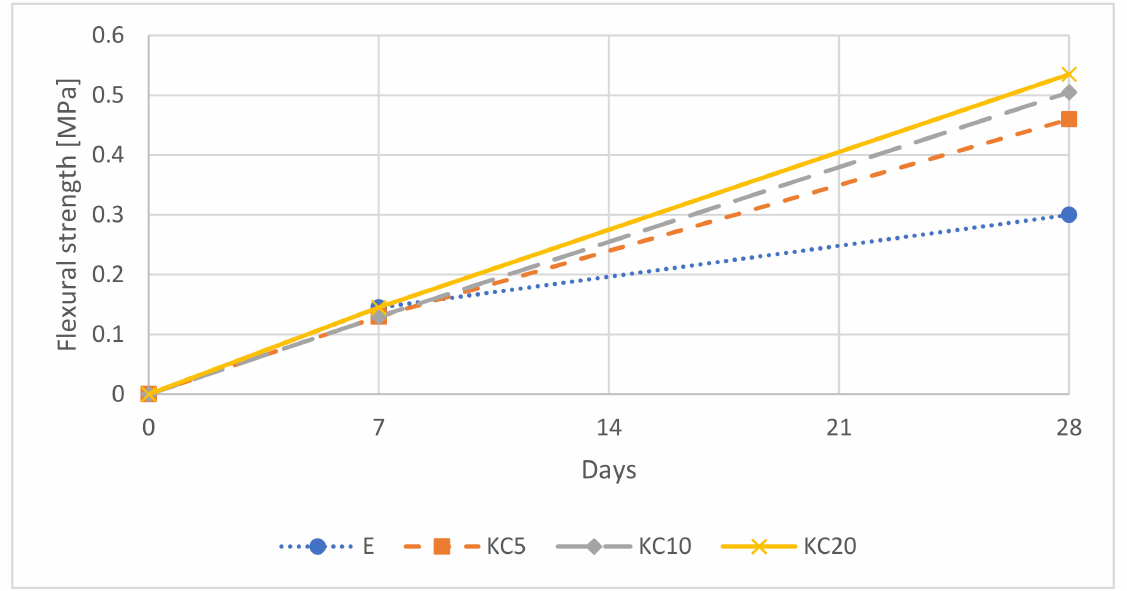
Figure 6. Development of flexural strength from 7–28 days in Series 2 (varied w/b ratio and percentage of WPC).